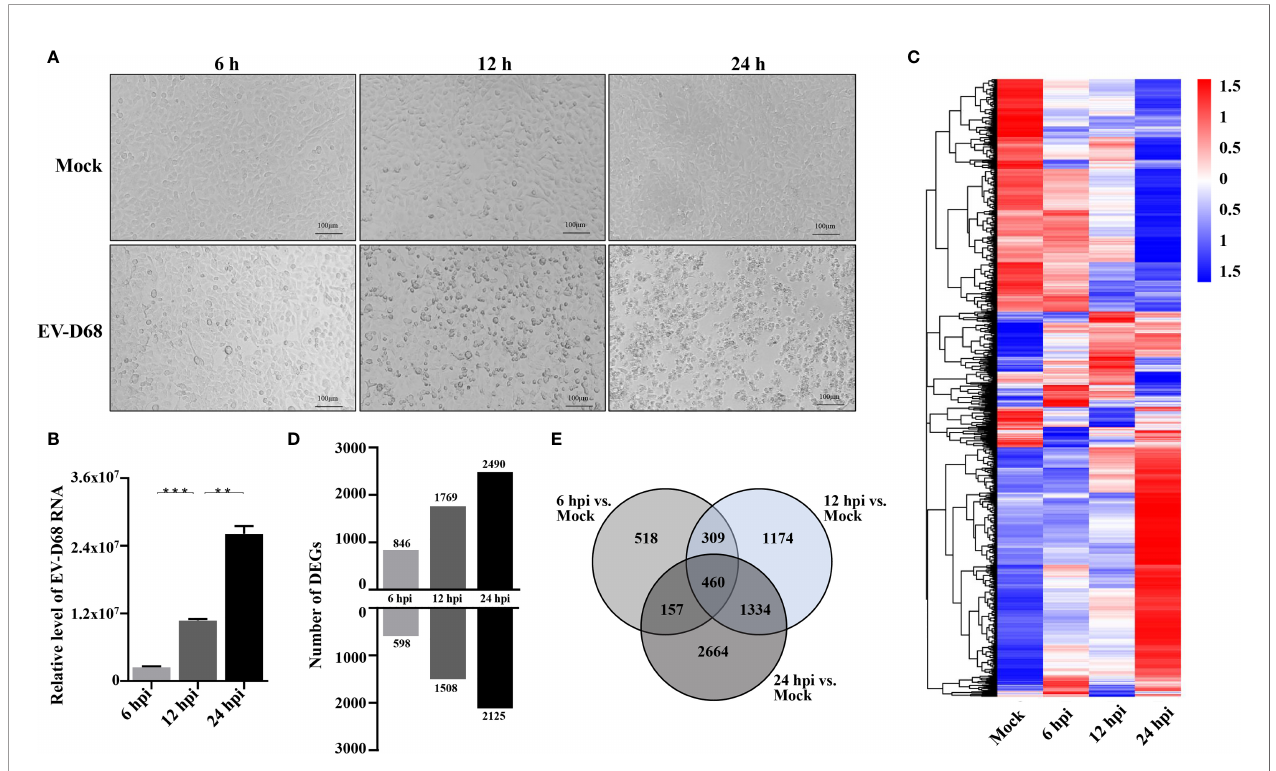
FIGURE 1 | Transcriptome landscape revealing host functional regulation in response to EV-D68 infection. (A) Detection of EV-D68-induced CPE. RD cells were infected with EV-D68 (MOI = 0.1), and were imaged via light microscopy at 6 h, 12h, and 24 h post-infection. (B) Replication of EV-D68 in RD cells. Cells in 24-well plates were infected with EV-D68 (MOI = 0.1) and collected at designated time points (6 hpi, 12 hpi, and 24 hpi). RT-PCR measurement of relative viral RNA levels. (C) Clustering heatmap showing differential gene expression between mock and EV-D68-infected groups. The ordinate is the normalized FPKM expression values of differential genes. Different colors show gene expression level differences, with high expression colored red and low expression colored blue. The closer the color distributions of the two samples, the more similar the expression patterns. (D) The number of DEGs at different infection time points. (E) Venn diagrams showing overlapping DEGs between different comparison groups. ** p < 0.01, *** p <